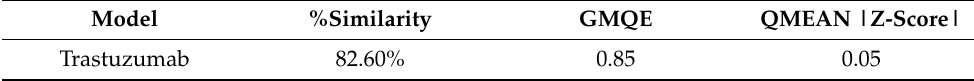
Figure 2. Trastuzumab modeling, resulting in: ( a ) 3D structure of trastuzumab, ( b ) comparison with non-redundant set of PDB structures, ( c ) heavy and light chain alignment. Table 3. Evaluation of trastuzumab modeling